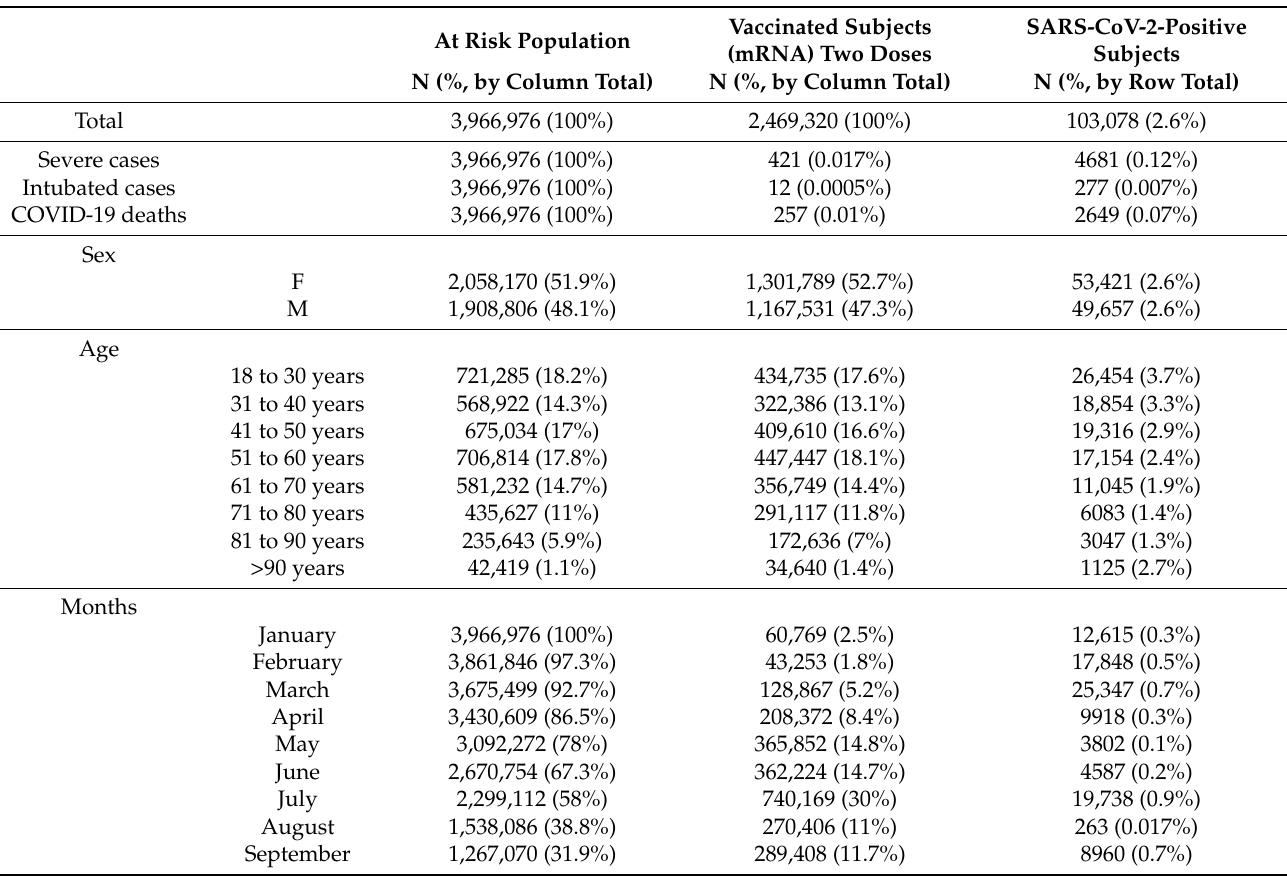
Table 1. Characteristics of the cohort of 3,966,976 Sicilian adults aged 18 years or more who were followed-up between January and September